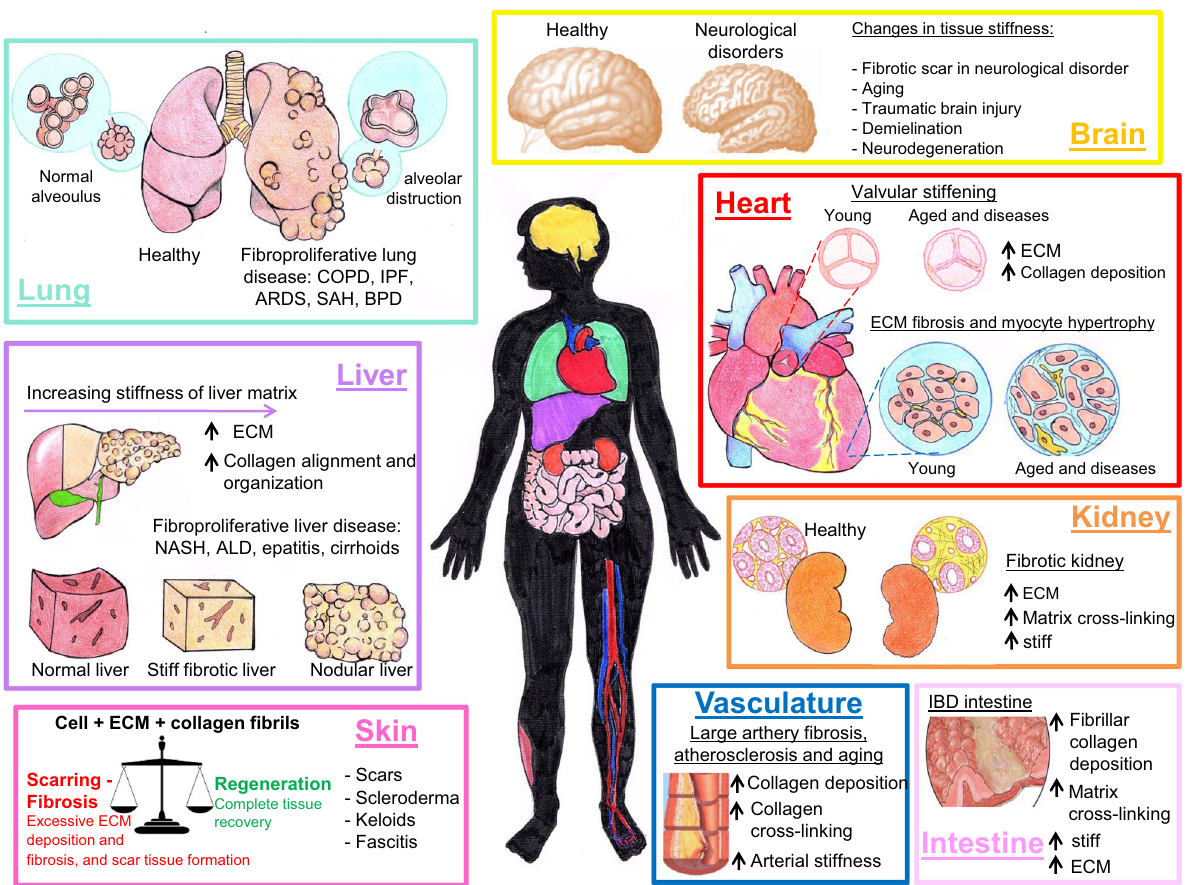
Fig. 1 Schematic overview of the major diseases in which tissue stiffness is altered. The hallmark of fi brosis is excessive extracellular matrix (ECM) synthesis and deposition that improve liver matrix remodeling and stiffening. In addition to change the amount of collagen deposited in the ECM, the alignment of the collagen fi brils is also contributing signi fi cantly to the alteration of the stiffness of tissues matrix. Increased matrix stiffness is not only a pathological consequence of fi brosis in traditional view but also recognized as a key driver in the pathological progression of fi brosis and cancer. Moreover, it is very likely that signi fi cant changes in cell and tissue mechanics contribute to age-related cognitive decline and de fi cits in memory formation which